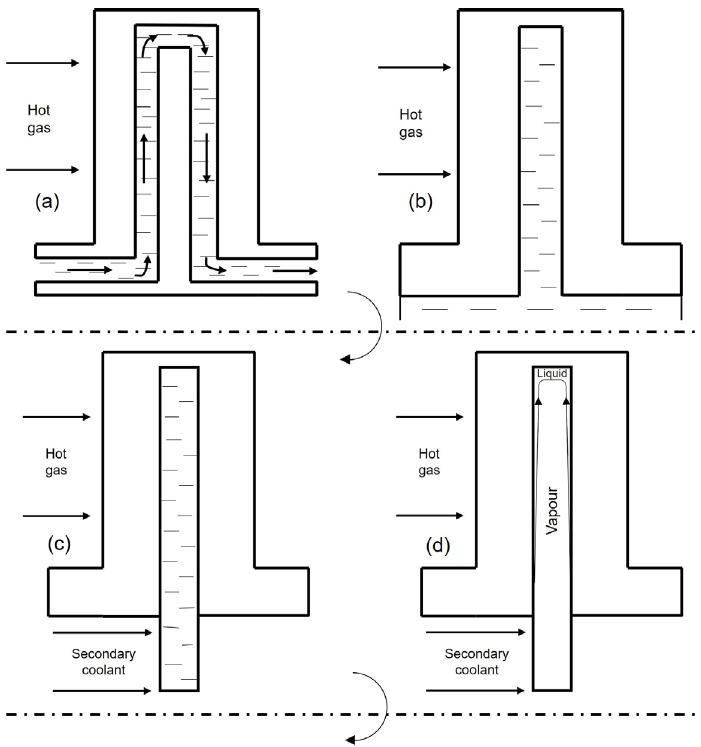
Figure 2. Schematic of: ( a ) forced convection cooling; ( b ) free convection open thermosyphon cooling; ( c ) free convection closed thermosyphon cooling; ( d ) two-phase closed thermosyphon cooling. Initially, considerable efforts were expended investigating forced convection coolant in 1951. The TIT achieved 1473 K, and the average blade surface temperature was